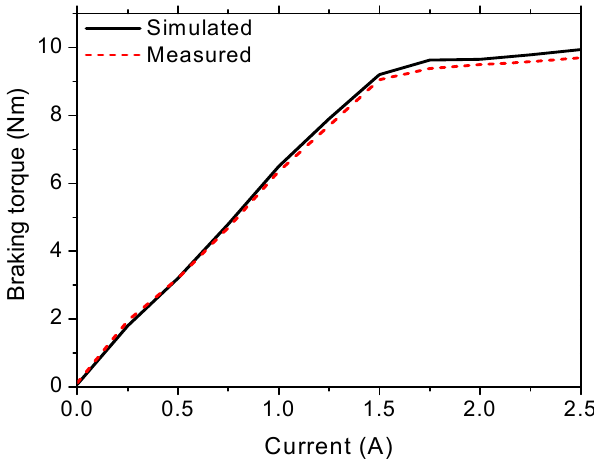
Figure 14. Braking torque of the shoulder MR brake vs. applied current.